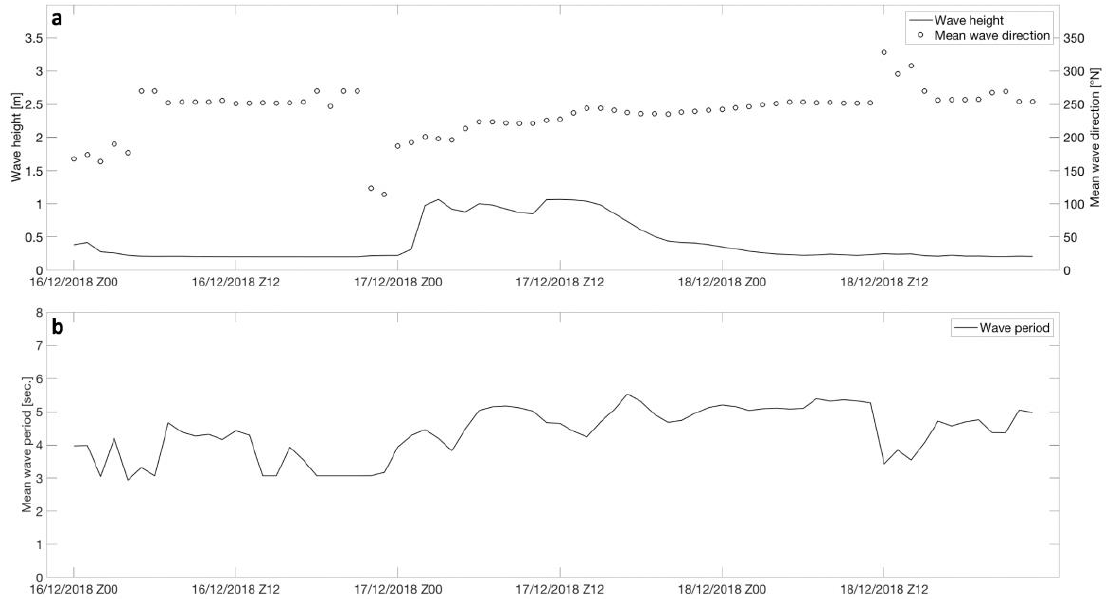
Figure 6. Calculation of wave height and direction ( a ) and wave period ( b ) in the study area between 16 and 18 December 2018. The simulation was performed using the WW3 numerical model.